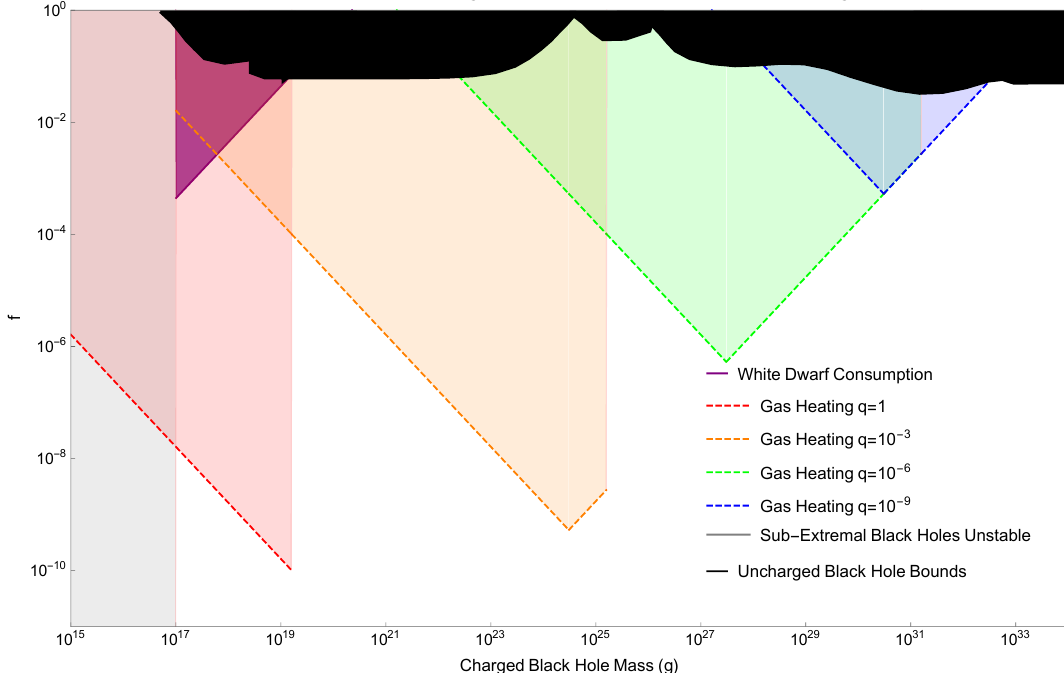
Figure 6 . These are the constraints on MBHs with M > 10 15 g. The purple region is excluded for all MBHs that satisfy eq. (5.5) due to WD consumption. The dashed lines represent bounds from overheating WIM clouds in the Milky Way. Each color traces the bound for MBHs with a different value of q . This bound tilts upward when a typical WIM cloud only encounters an MBH once every 10 5 years. The bound cuts off when MBHs lose an O (1) fraction of their kinetic energy to friction with the WIM clouds within 10 Gyr. MBHs are unstable on cosmological timescales if q 6 = 1 in the gray region [18]. Bounds on uncharged black holes applicable to MBHs are shown in black [81].